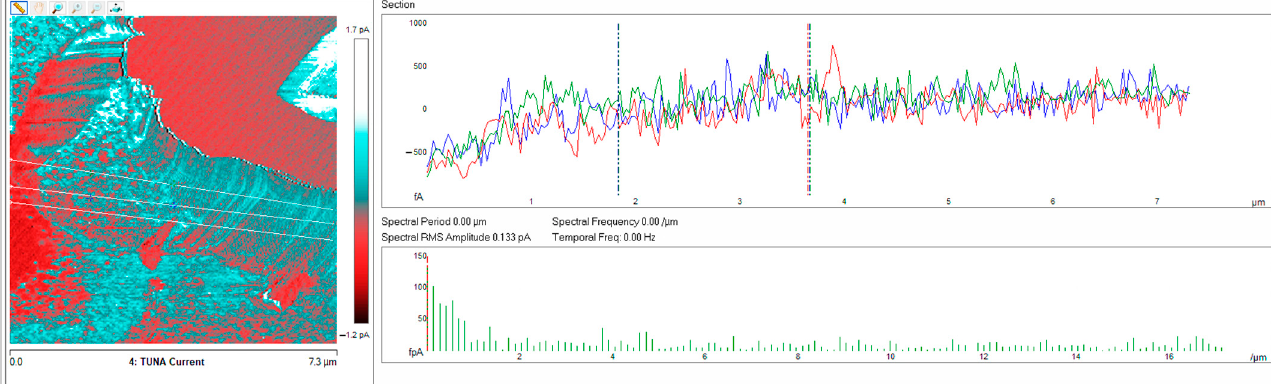
Figure 15. From left to right, TUNA Current picture and current variation profile of the sample TCTBD+0.5%MWCNT.